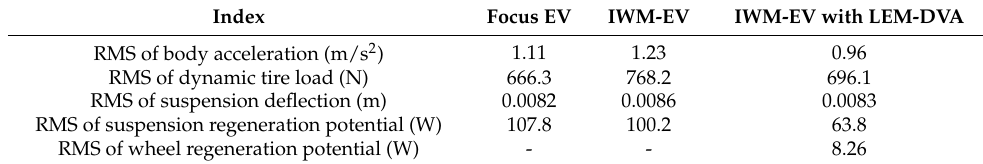
Table 2. Performance comparison (simulation).